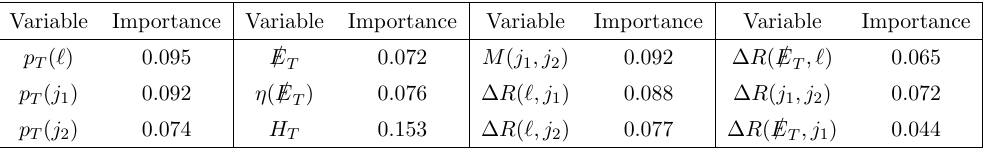
Table 3 . Input variables used for MVA (BDT algorithm) and their relative importance. These numbers are obtained for m = 300 GeV for the 2 b -tag category. These numbers can vary for H (cid:6) other choices of